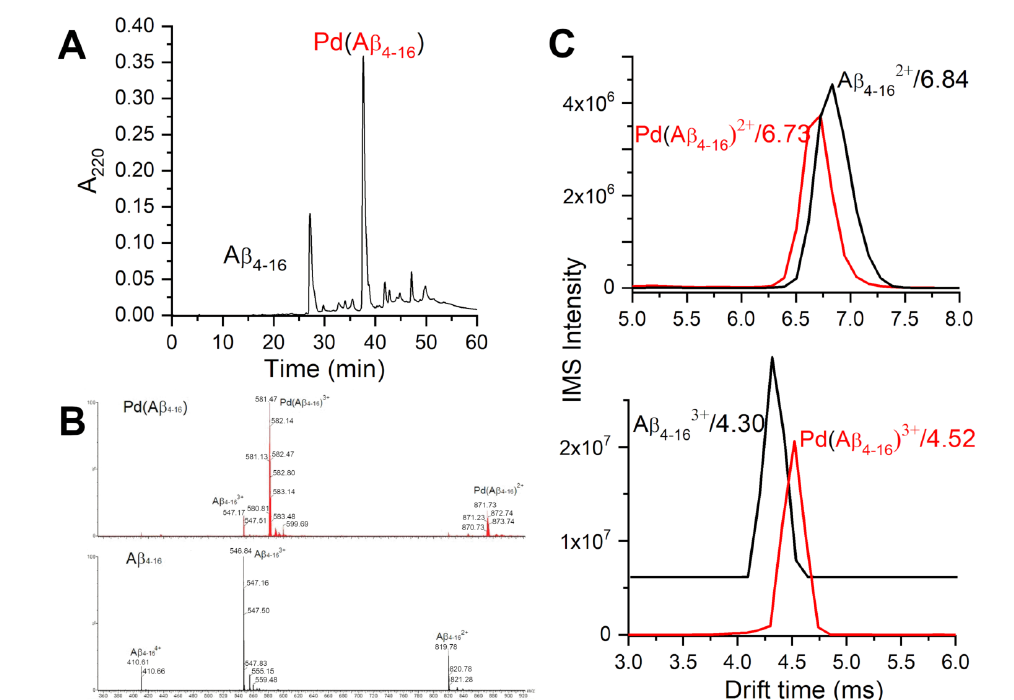
Figure 2. HPLC/MS characterization of products of the two-step procedure of obtaining the Pd(A β 4 − 16 ) samples. ( A ) HPLC chromatogram of the sample containing initially 0.5 mM A β 4 − 16 and 0.425 mM K 2 PdCl 4 . ( B ) ESI-MS spectra of the respective HPLC peaks. ( C ) IMS characterization of A β 4 − 16 and Pd(A β 4 − 16 ) species at pH